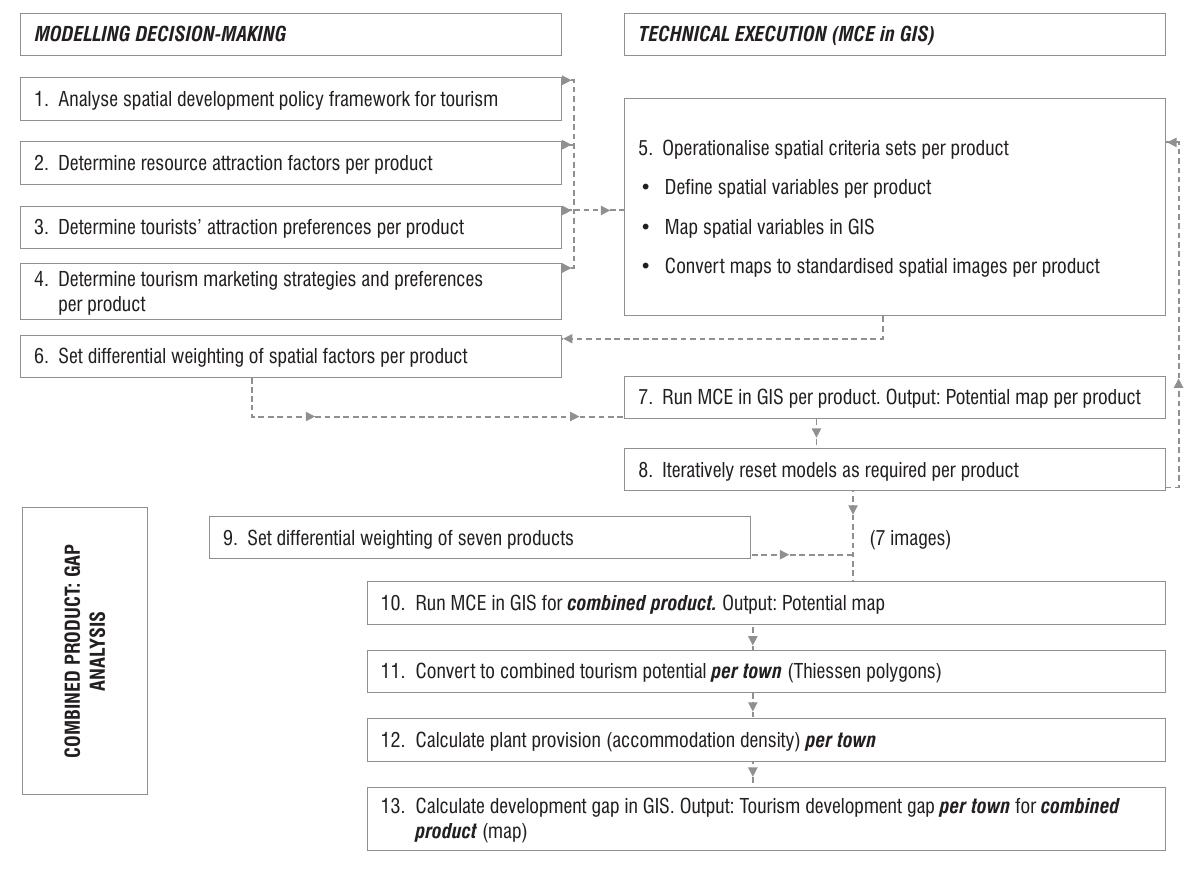
Figure 1: Flowchart of procedures for multiple criteria evaluation (MCE) and gap analysis using a geographical information system